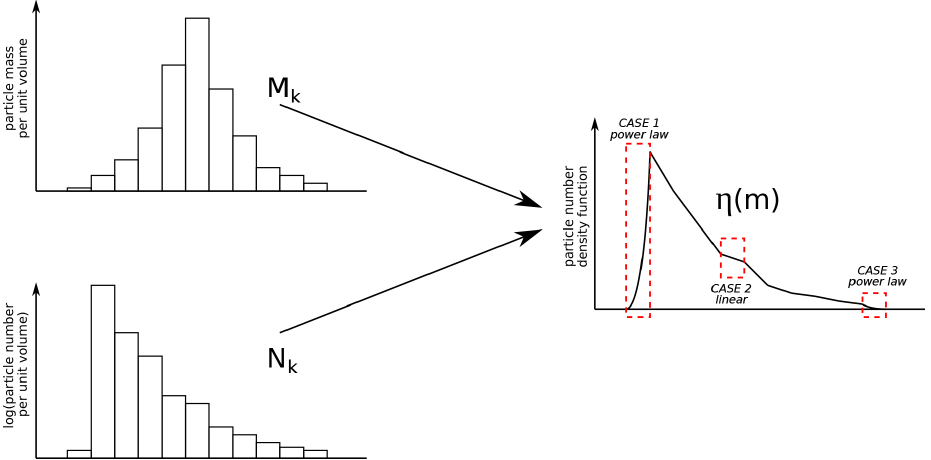
Figure 2. Piecewise reconstruction of the number density function from the local moments. The values of the first two moments in each section (plotted on the two bar plots on the left) are used for the reconstruction of the piecewise continuous density function. The function is linear in the internal sections and a power law at the boundaries.